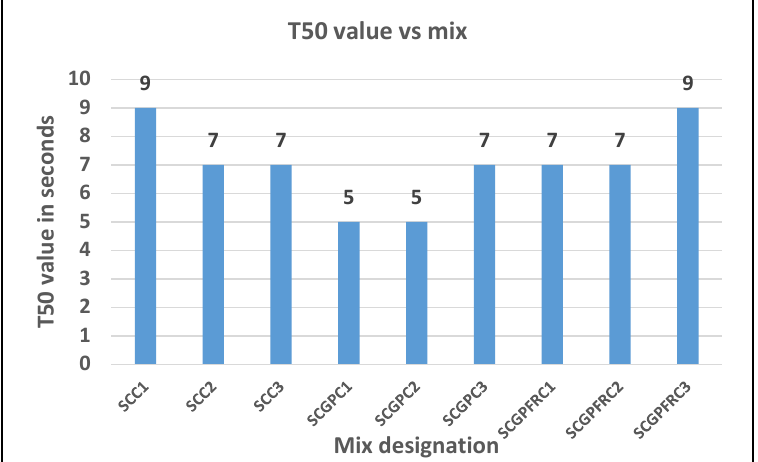
Fig. 5. Graph showing the variation of L-Box test values for all mixes.